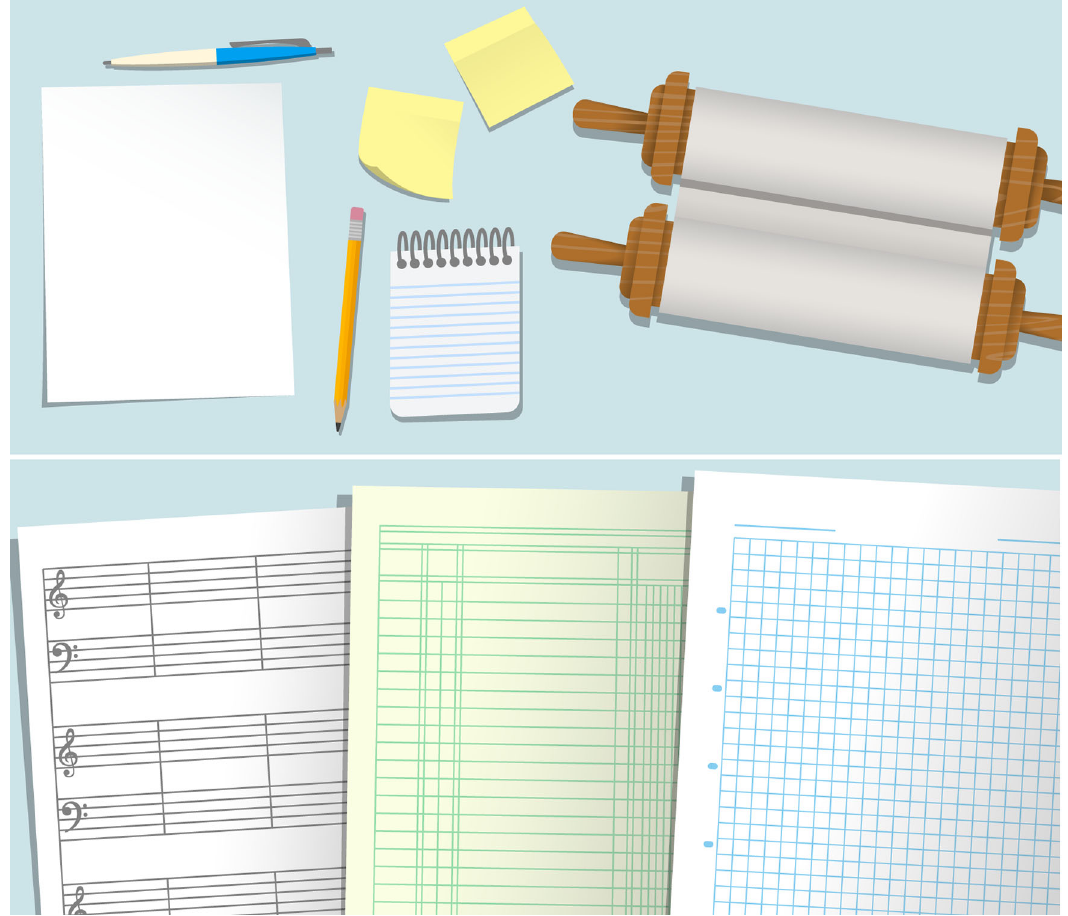
Figure 3. R objects have physical analogues. Diverse data structures are used in R to store different kinds of data. This is analogous to the use of various objects as shown in the illustrations to store data in non-digital